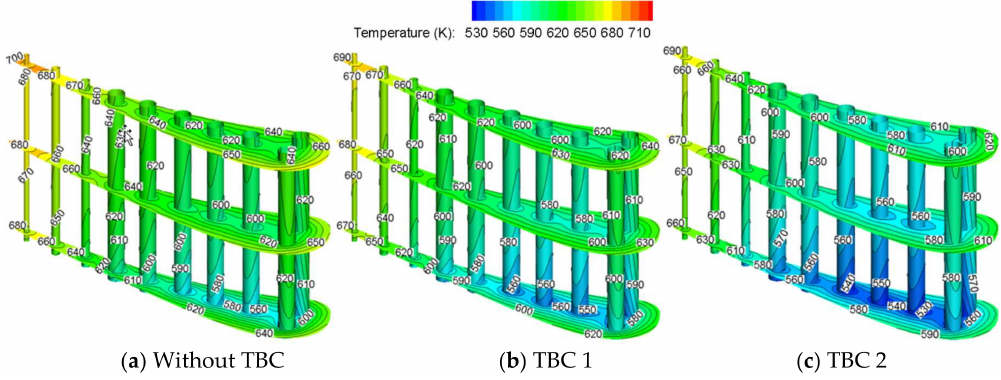
Figure 15. Contours of vane internal temperature of at Tu = 8.3%.